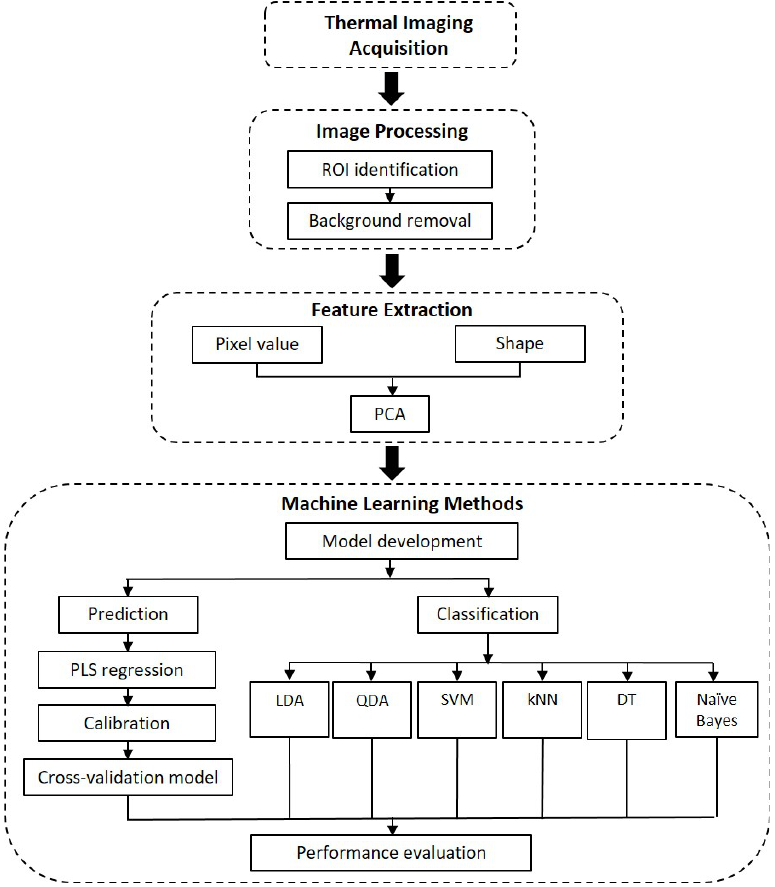
Figure 3. Flowchart for the classification of pineapple cultivars using infrared thermal imaging technique.